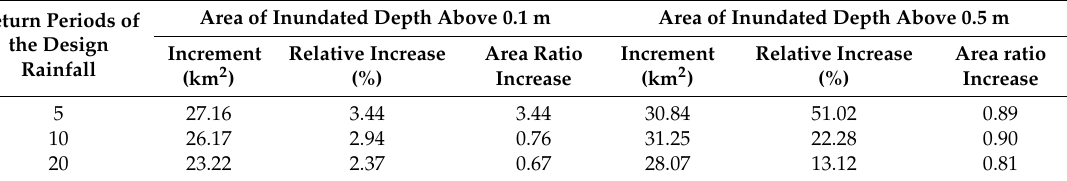
Table 6. The increment of the waterlogging area as the lake water level rises from condition 2 (cid:13) to condition 3 (cid:13)